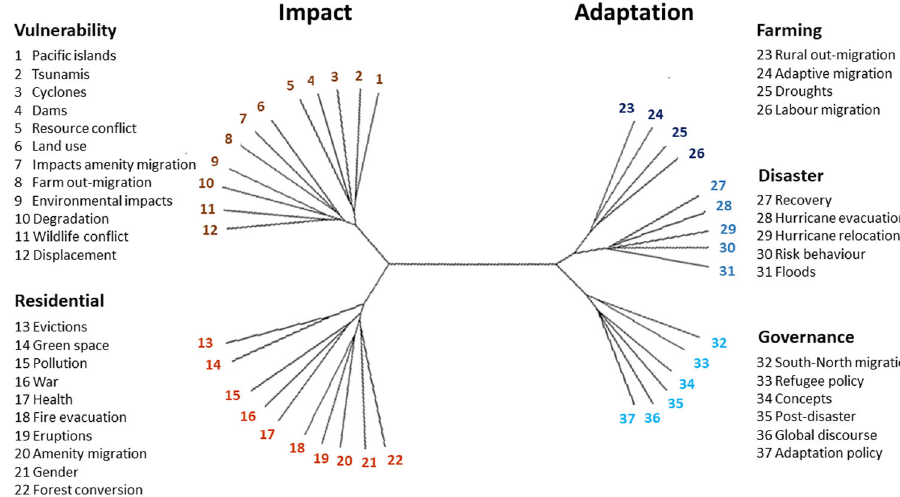
Fig. 2 Phylogram of the topic model. Similarities across the 3197 articles showing two deeply branched themes, fi ve clusters and 37